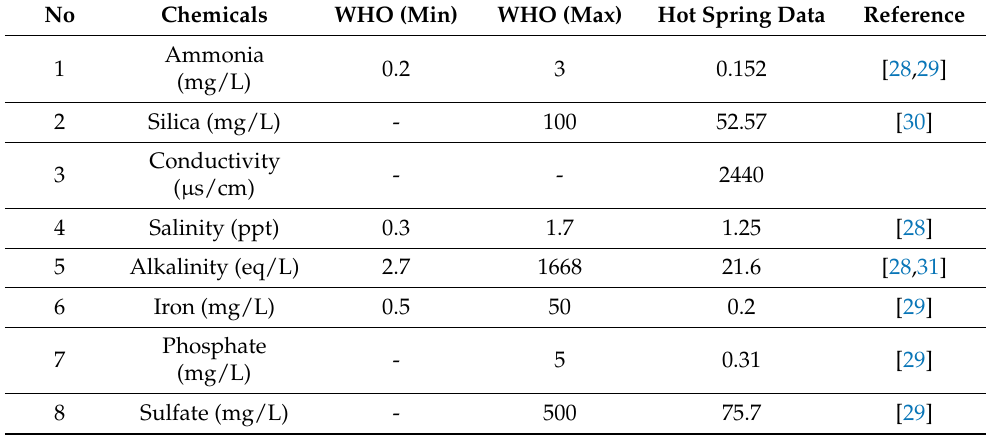
Table 4. The comparison of chemicals from the hot springs and the WHO standards.